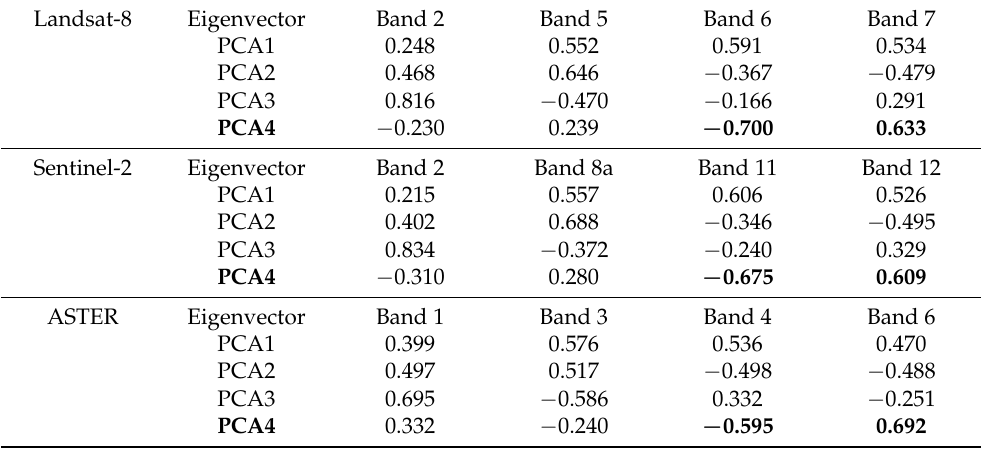
Table 5. The eigenvector matrixes of PCA results for mapping hydroxyl-bearing minerals using different remote sensing data; Bold text represents the selected PCA and the unique eigenvalues. Landsat-8 Eigenvector